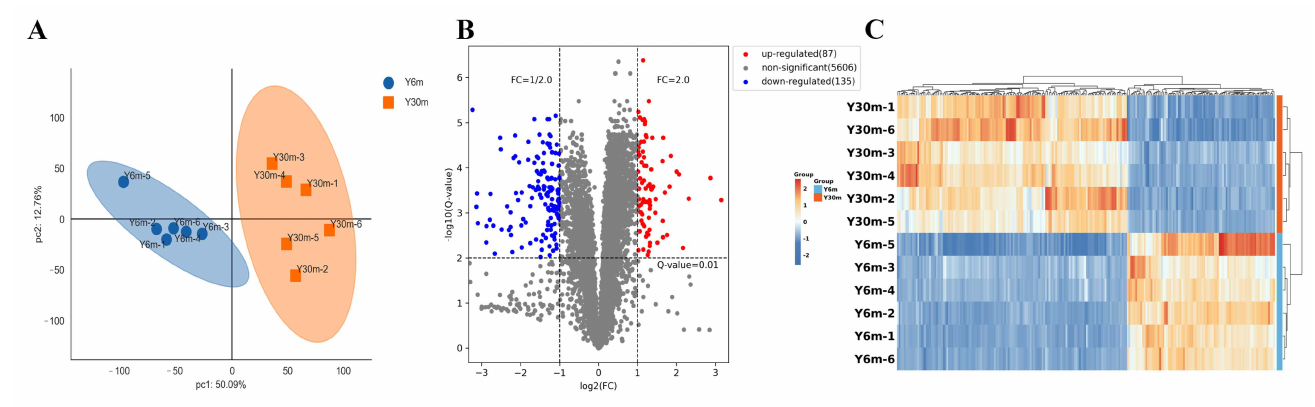
Figure 4. Overview of proteome sequencing data. ( A ) PCA diagram of two sample groups. ( B ) Differential protein volcano map. ( C ) Cluster analysis of differential